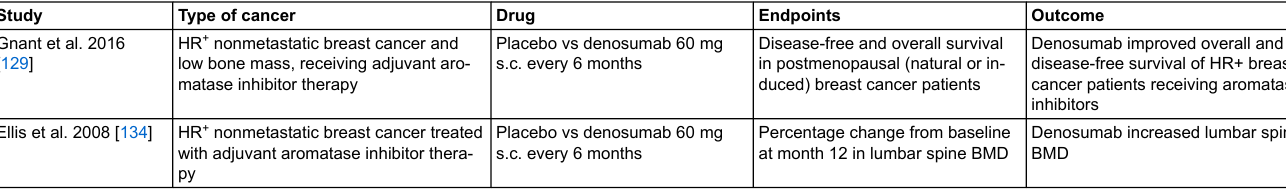
Table 3: Phase III trials with bone targeting agents in nonmetastatic breast cancer.